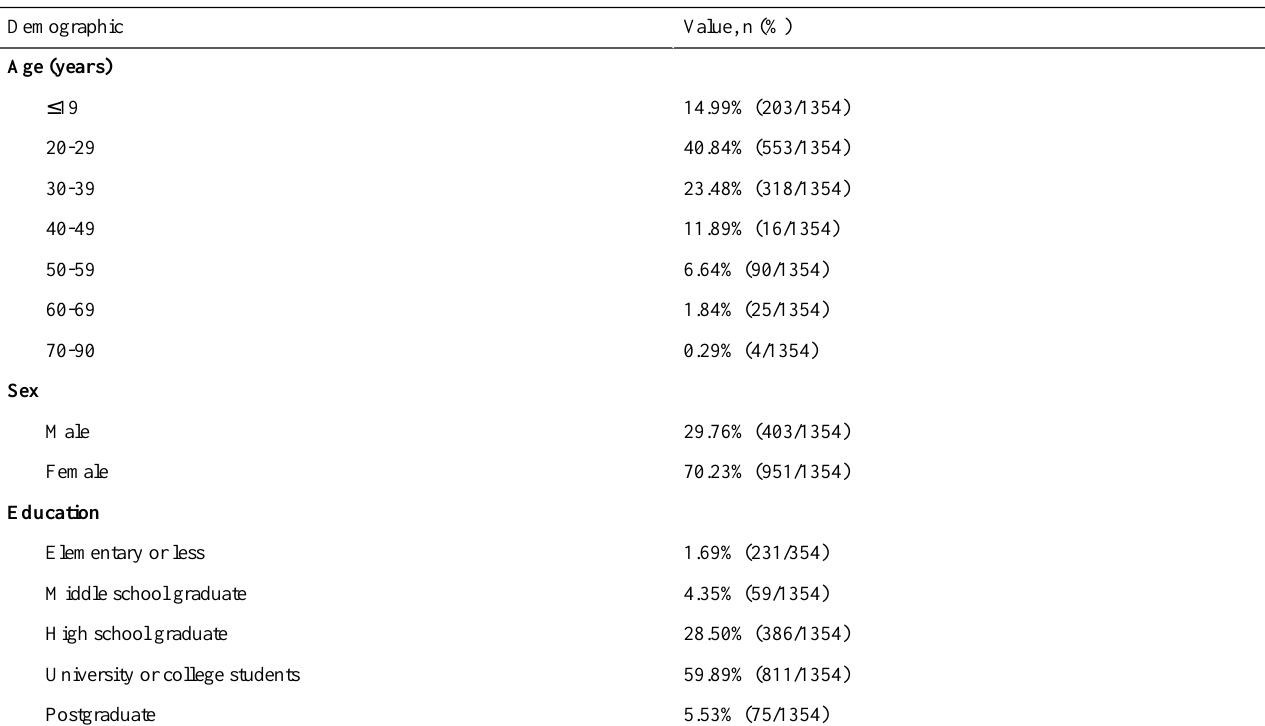
Table 1. Participant demographics